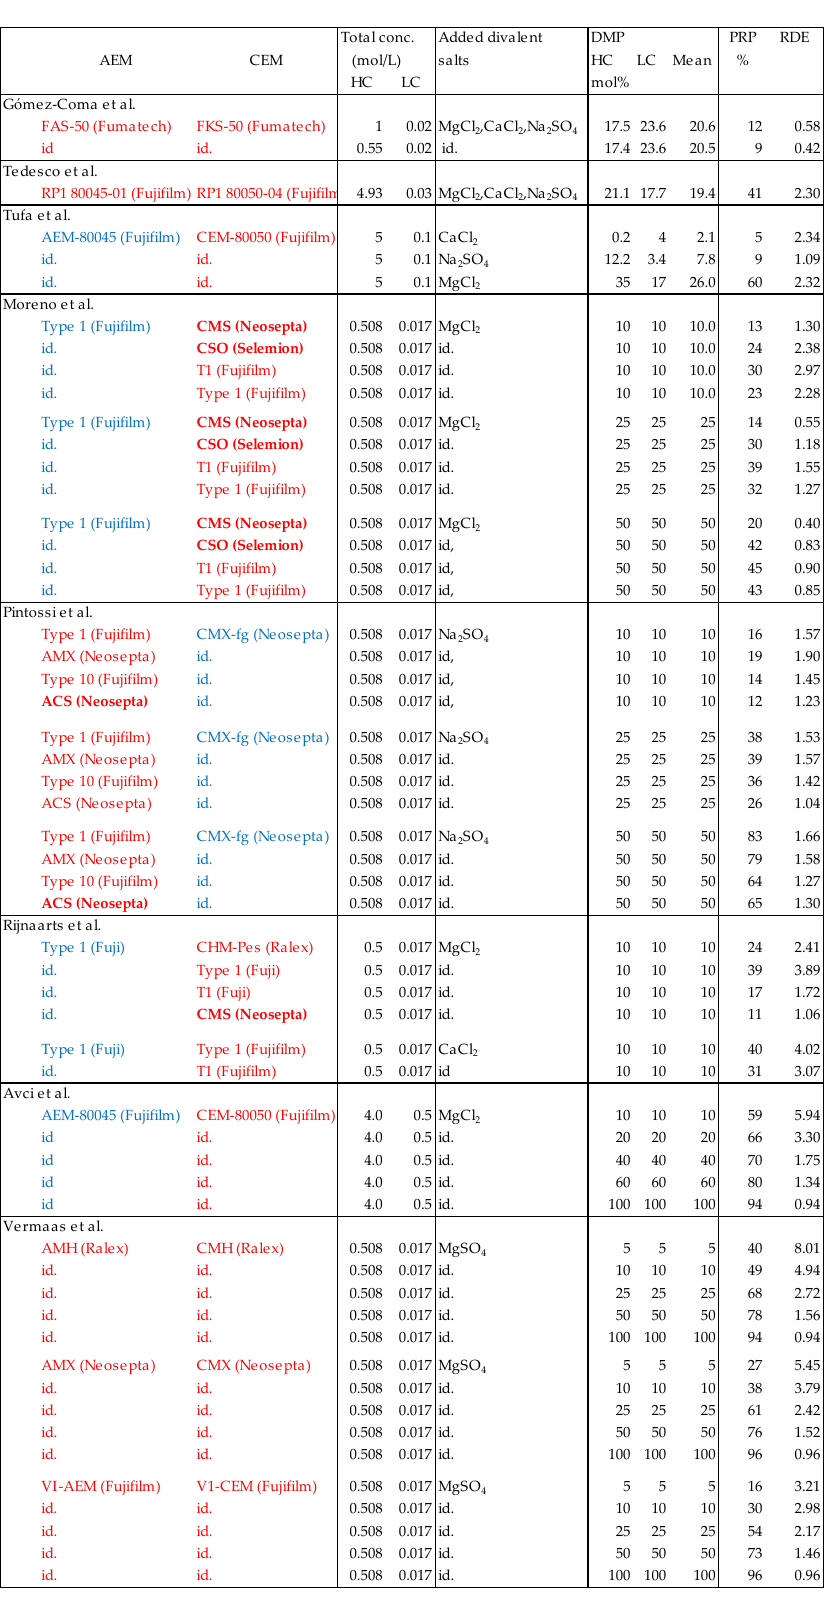
Figure 10. Power reduction percentage ( PRP ) and relative divalent effect ( RDE ) of divalent ions in different membranes. Target membranes are shown in red and auxiliary membranes in blue text. Monovalent selective membranes are shown in bold letter